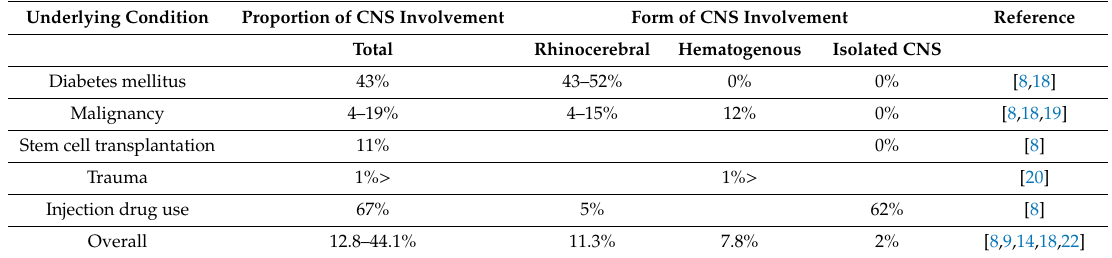
Table 1. Patterns of Central Nervous System (CNS) mucormycosis in di ff erent patient